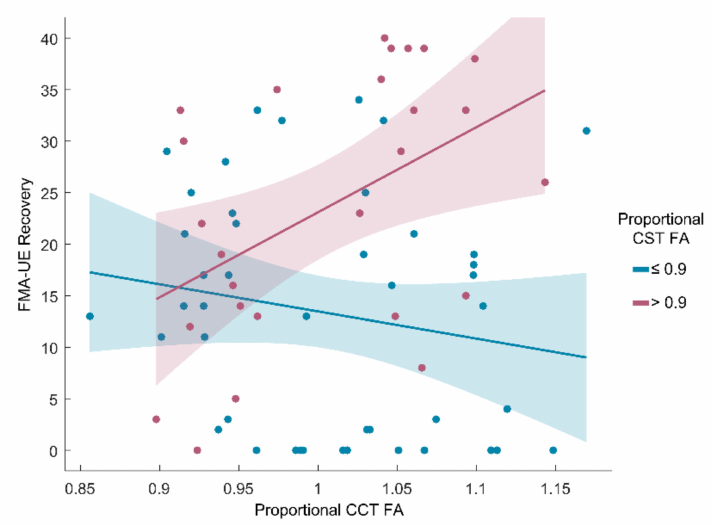
Figure 3. Relationship between the CCT FA and FMA-UE recovery in subgroups divided by CST integrity (proportional CST FA cutoff = 0.9). The CCT FA was significant in patients with high CST FA ( n = 26, R 2 = 0.223, p = 0.015) but not in patients with low CST FA ( n = 44, R 2 = 0.031, p = 0.252). FMA- UE, Fugl–Meyer Assessment-Upper extremity; CST, corticospinal tract; CCT corticocerebellar